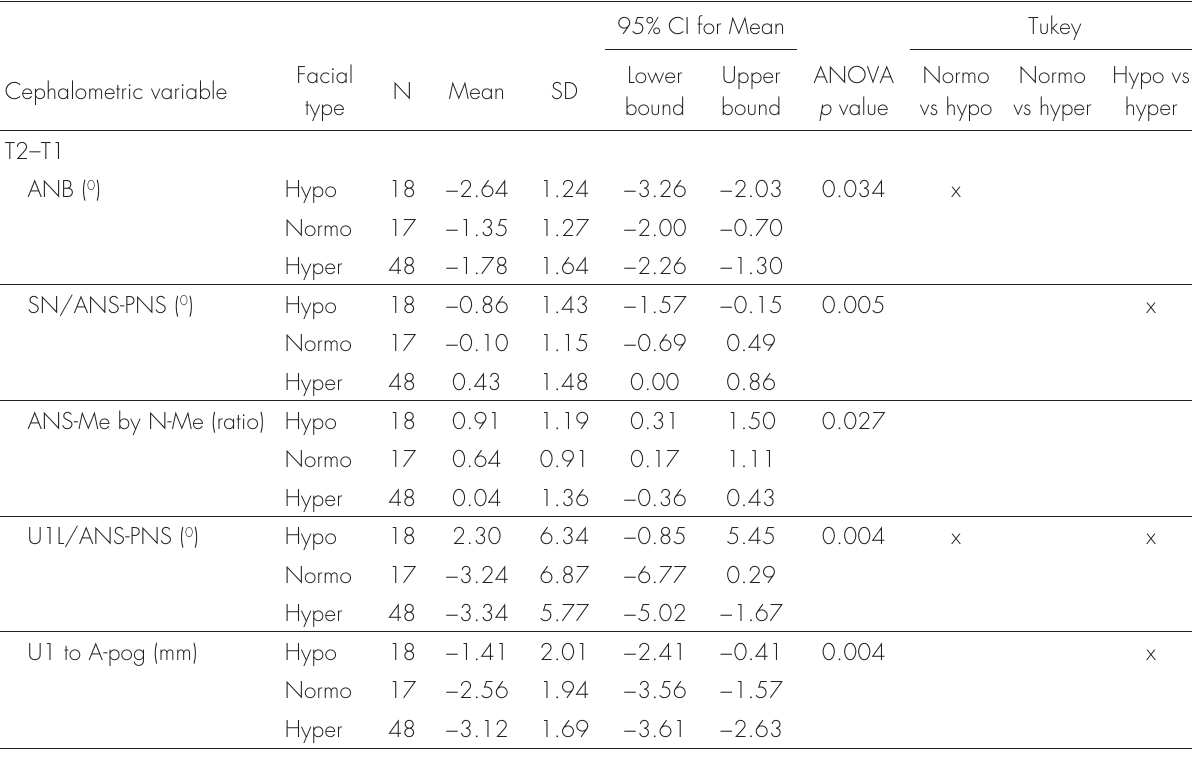
Table V. ANOVA followed by Tukey’s post hoc test for the differences in the increments of the cephalometric variables for the three facial